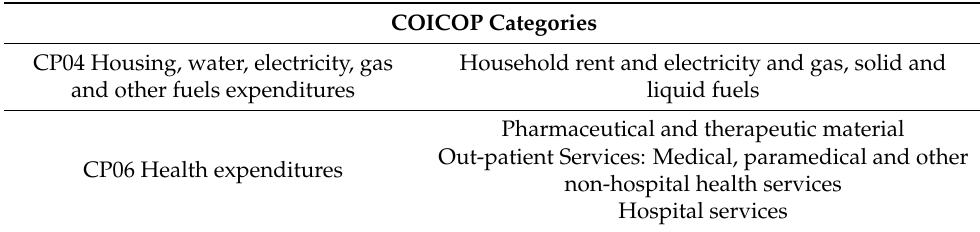
Table 1. COICOP definition and commodity breakdown (source: